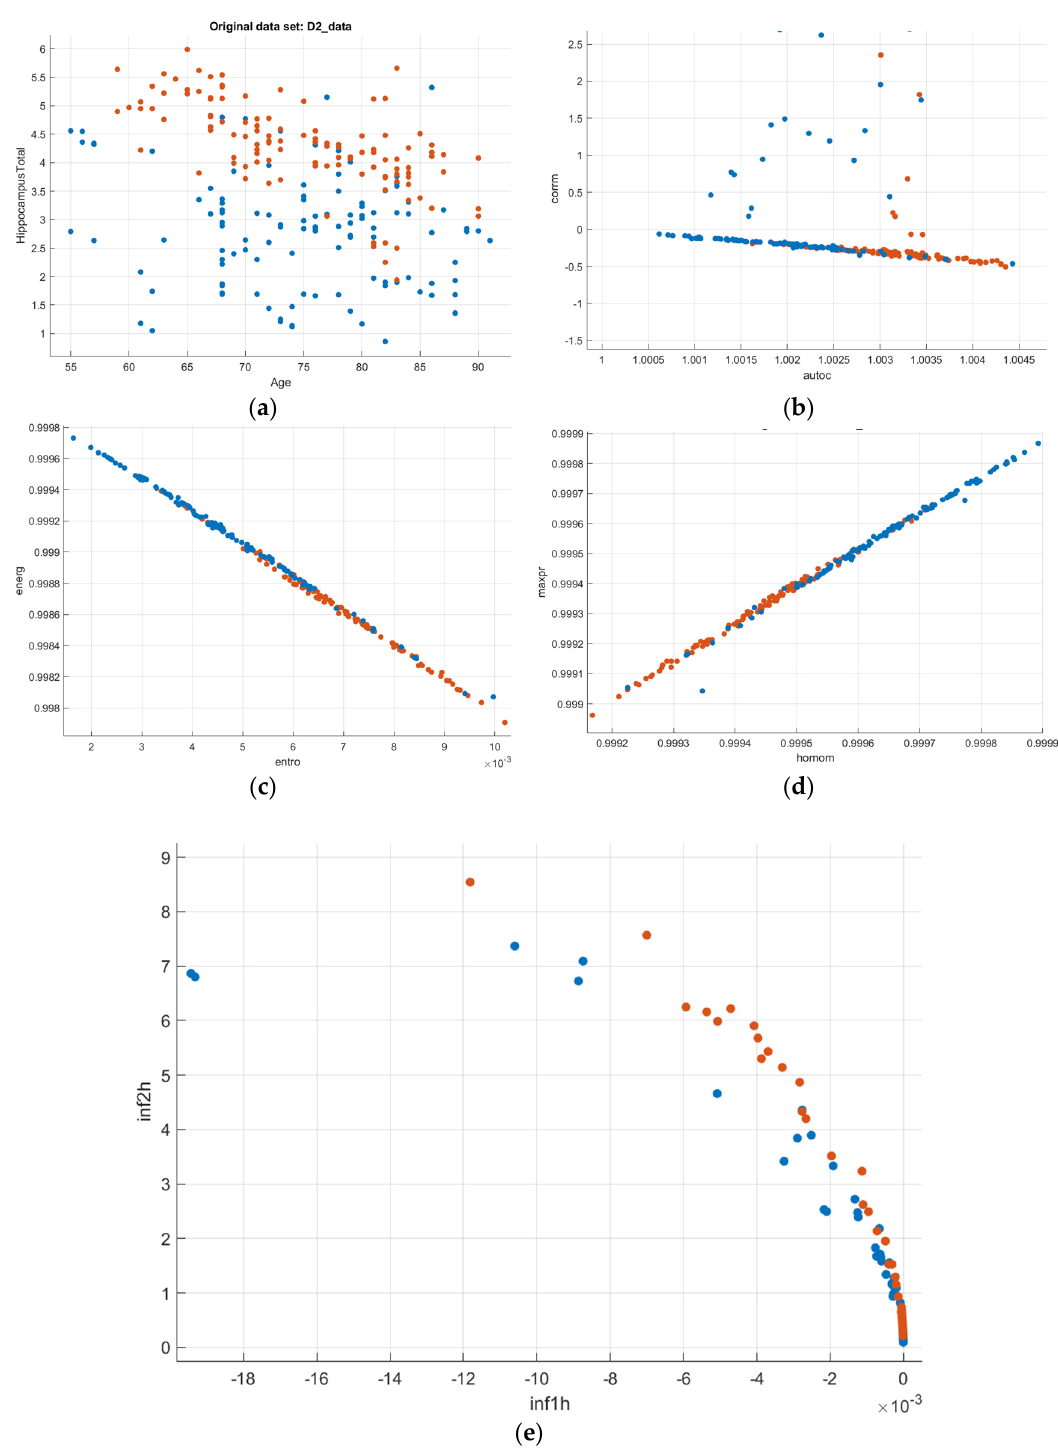
Figure 10. Scatter–plot representation of the GLCM features (AD-Blue, CN-Orange): ( a ) Age vs. Hippocampus Volume; ( b ) Autocorrelation vs. Correlation; ( c ) Entropy vs. Energy; ( d ) Homogeneity vs. Maximum Probability; ( e ) Information measures of correlation 1 and 2.